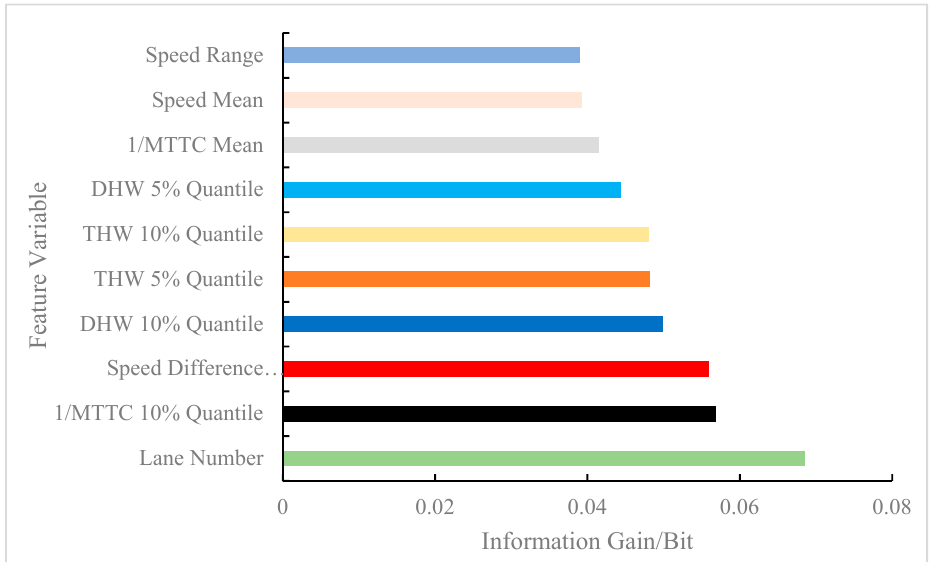
Figure 9. Information gain of feature variables (only the top 10 were counted).